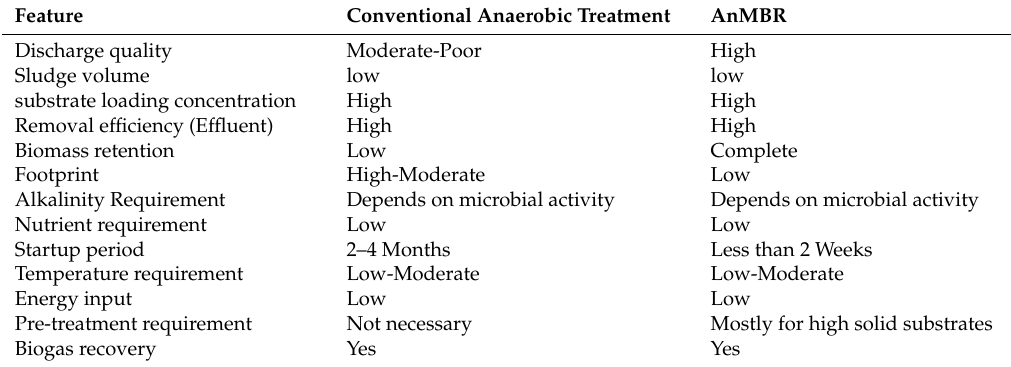
Table 1. Comparison of conventional anaerobic treatment and anaerobic membrane bioreactor (AnMBR)